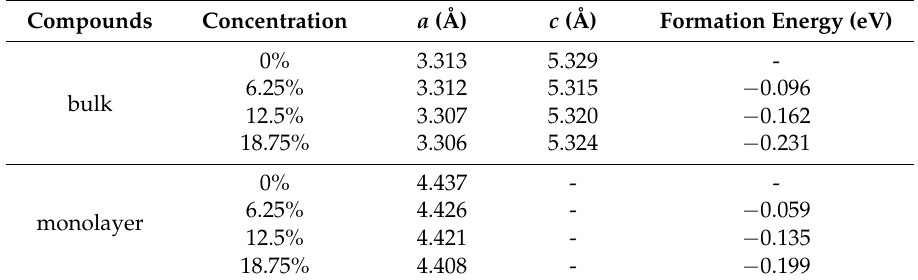
Table 1. The lattice parameters and formation energies of Al-doped ZnO bulk and